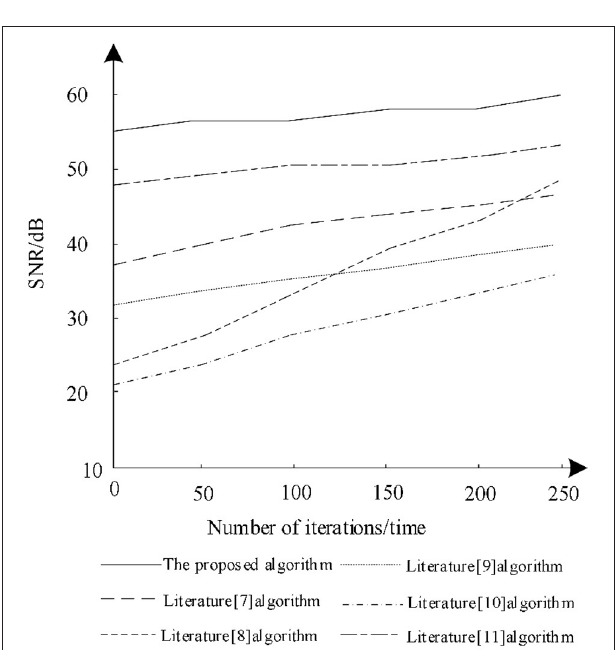
FIGURE 5 | Comparison of the signal-to-noise ratio (SNR) variation of different algorithms.